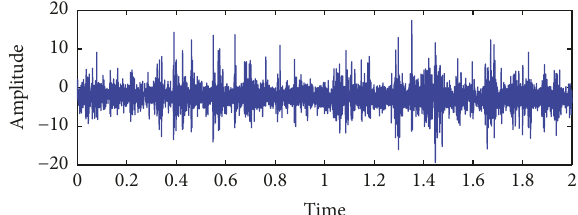
Figure 12: The vibration signal obtained from the fault gear.